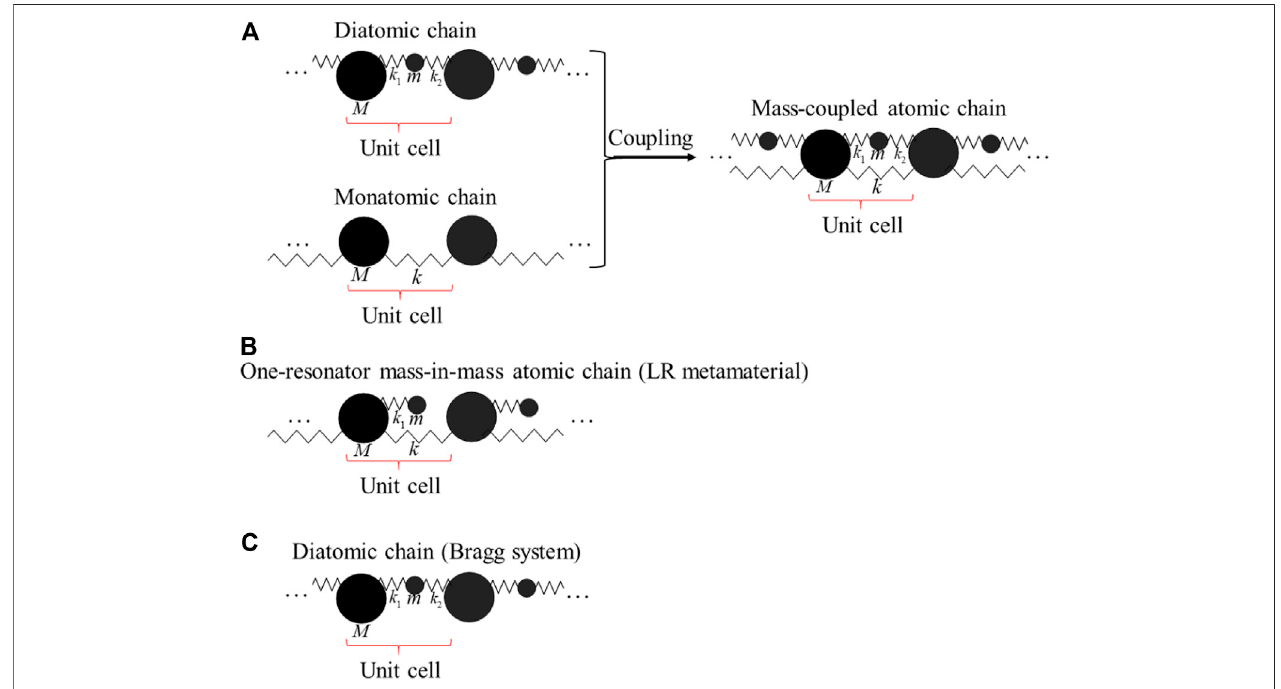
FIGURE1|(A) Themass-coupledatomicchaincoupledbyadiatomicchainandamonatomic chain. (B) One-resonatormass-in-massatomicchain. (C) Diatomic chain.